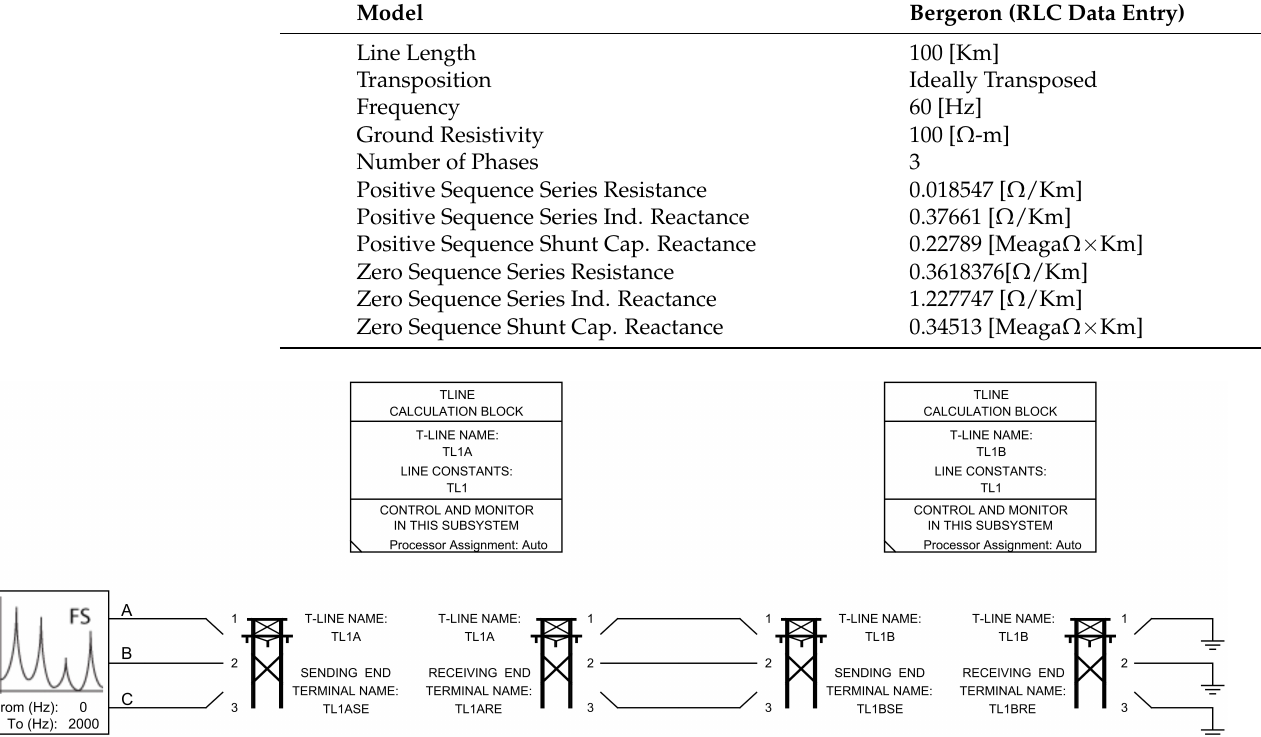
Figure 16. RTDS circuit Line Diagram of FRA